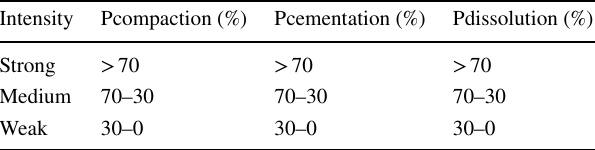
Table 4 The classification standard of influence extent on reservoir quality of compaction, cementation and dissolution of Oligocene sandstone reservoirs in the Lengdong area